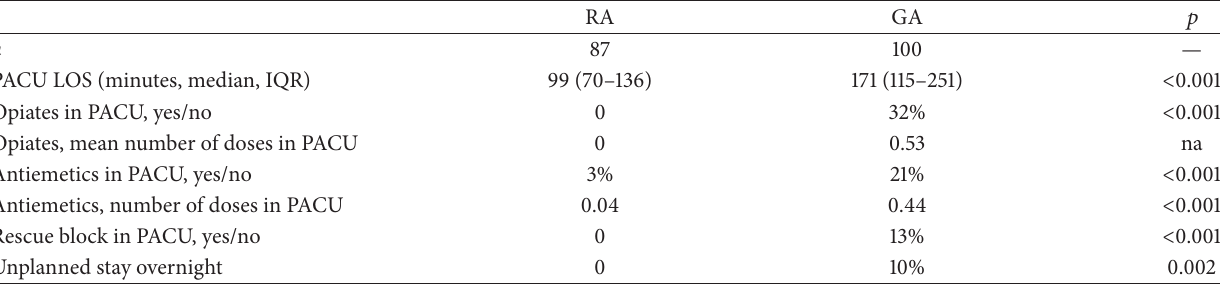
Table 2: Outcome in the two groups.